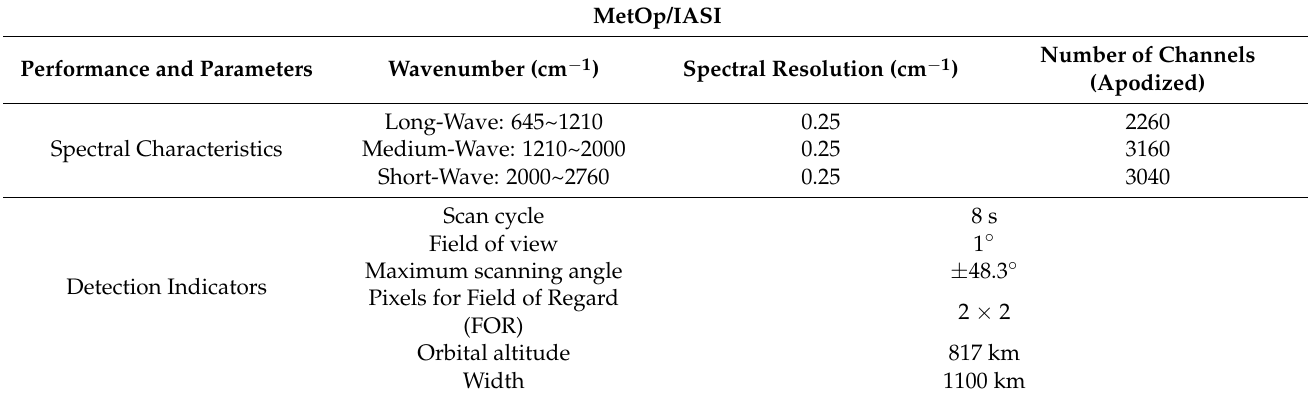
Table 2. MetOp/IASI spectral characteristics and detection indicators.